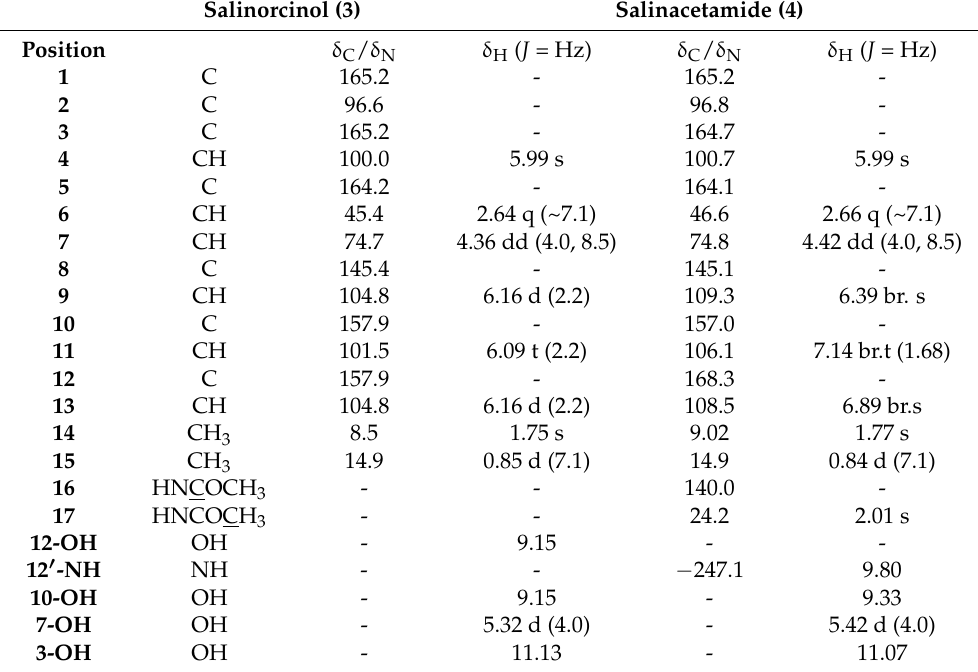
Table 1. NMR data for salinorcinol ( 3 ) and salinacetamide ( 4 ) recorded in DMSO- d 6 at 600